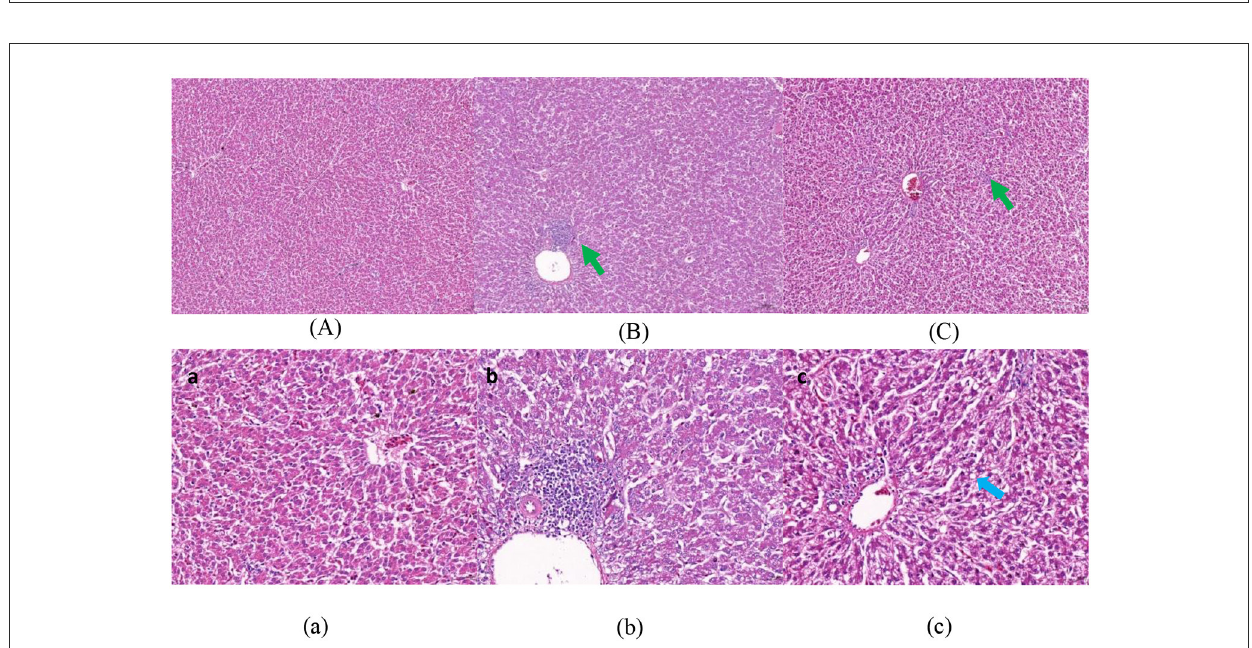
FIGURE2 The effect of non-fasting molting on the morphology of liver tissue (stage II). (A, a) Not treated with centralized molting; (B, b) fasting molting; (C, c) non-fasting molting. Upper-case letters are × 100, lower-case letters are × 400. Green arrows represent hepatocellular edema and blue arrows indicate the occurrence of